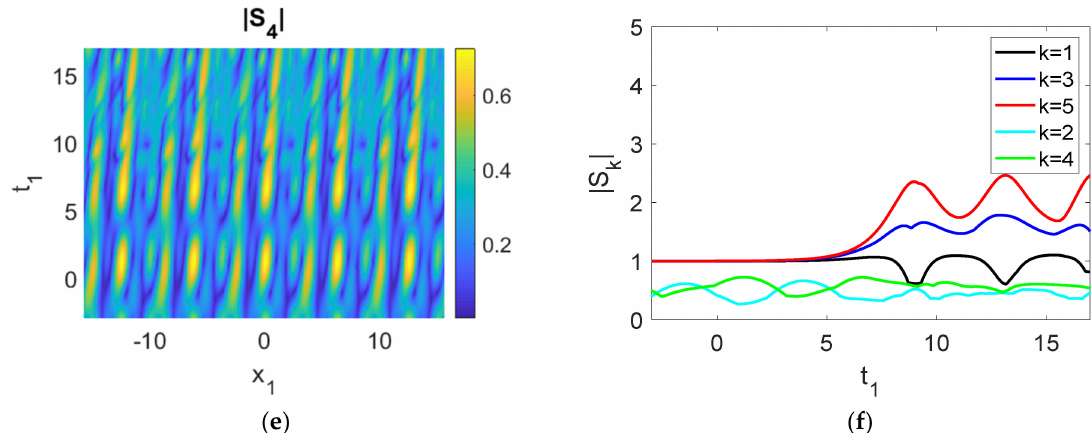
Figure 6. ( a – e ) The evolution of five wave components; ( f ) time history of the moduli of the envelopes, | S k |. Parameters used were c g 1 = 2, c g 3 = 1, c g 5 = 0.5, c g 2 = − 0.1, c g 4 = 0.1, γ 1 = 1, γ 3 = − 1, γ 5 a = − 1, γ 2 = − 0.5, γ 4 = 0.5, γ 5 b = − 0.01, a 2 = 1, ρ 1 = ρ 3 = ρ 5 = 1, ρ ρ δ = 0.4. 2 = 4 = 0.1,